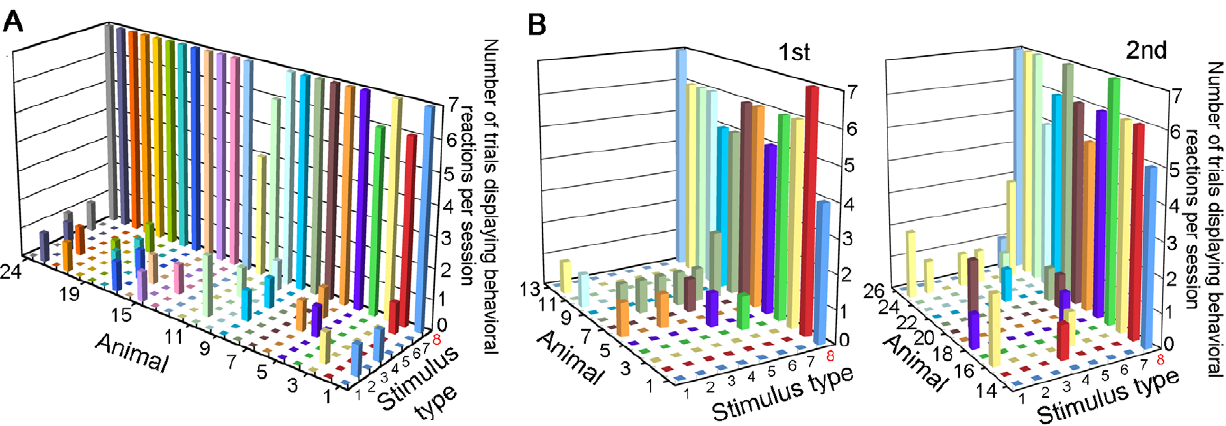
Figure 4. Graphs showing the number of trials displaying the behavioral reactions to target and non-target sounds. A . Responses to target (8) and non-target (1–7) sounds in the confirmation tests carried out as the last session of training. B . Responses to target and non-target sounds included in the recognition tests. Recognition tests were carried out one day after the confirmation test ( left , 1st test; right , 2nd test). X-axis shows sound types: 1, tap water; 2, clapping hands; 3, hitting plastic carrier; 4, hitting metal plate; 5, scratching metal mesh; 6, jingling keys; 7, human vowels; and 8, footstep sound (target). Y-axis, animals tested. Note that each stimulus type is repeated 7 times per session; thus, the maximum number of positive trials is 7 (z-axis). p . 0.5 for any pair between non-target sounds, while p , 0.01 for any pair between target and non-target sounds (see text for statistical details).